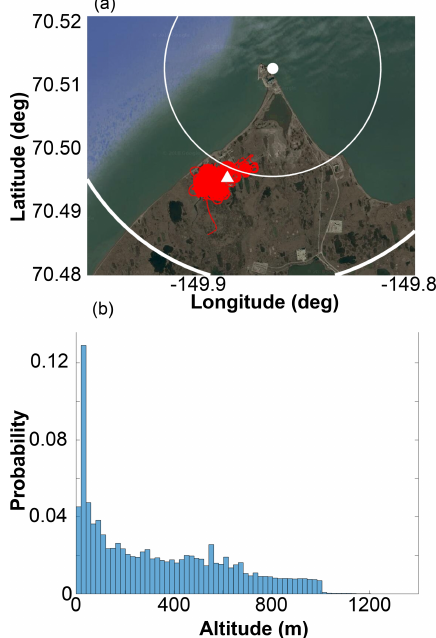
Figure 8. A spatial map of the POPEYE DataHawk2 flight loca- tions ( a , red dots), including white range rings at 1 and 2 nautical miles demonstrating the extent of R-2204 and the location of the AMF-3 (white triangle). Panel (b) is a relative frequency distribu- tion of the altitudes sampled by the DataHawks during POPEYE. Satellite imagery was “Built with ©Google Maps”, using their Ap- plication Programming Interface